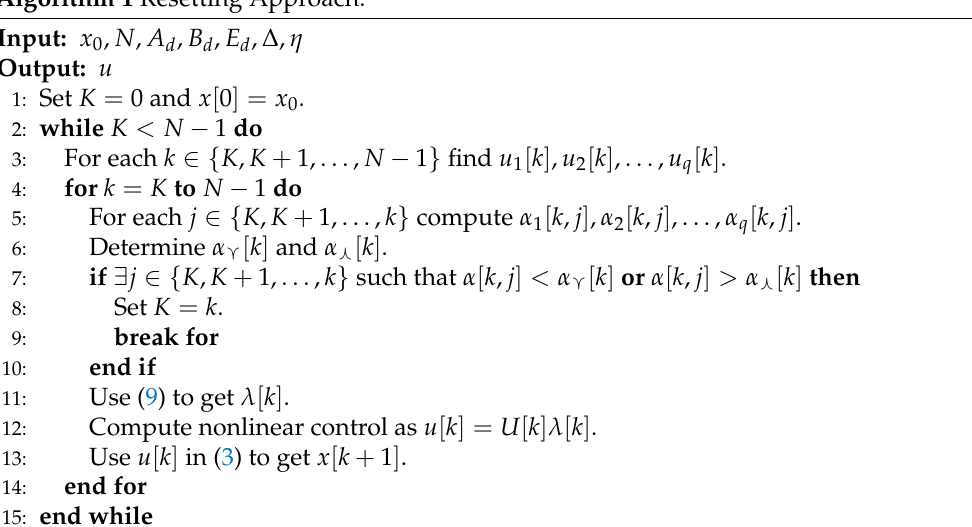
Algorithm 1 Resetting